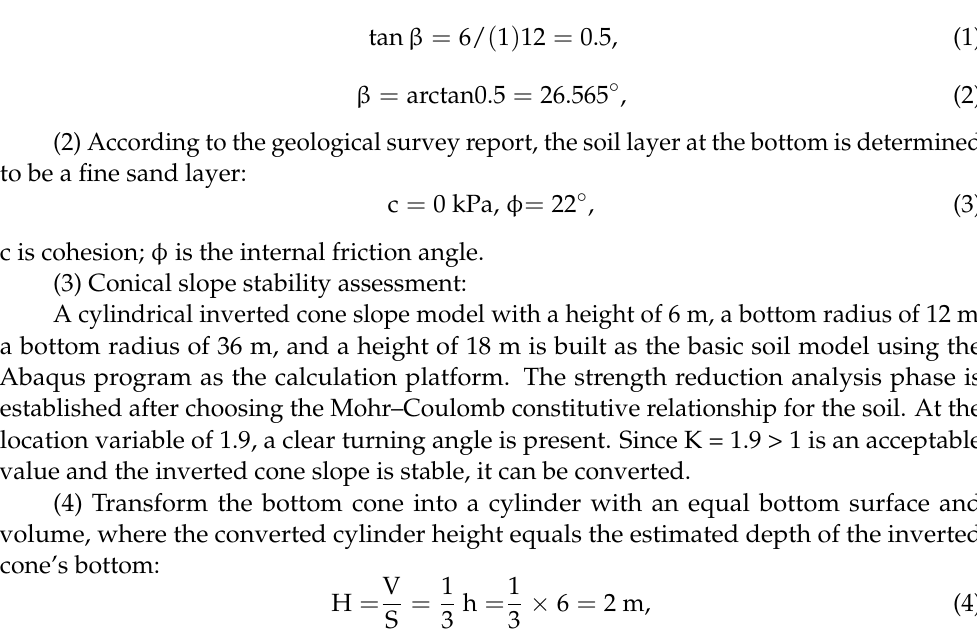
Figure 3. Granary structure